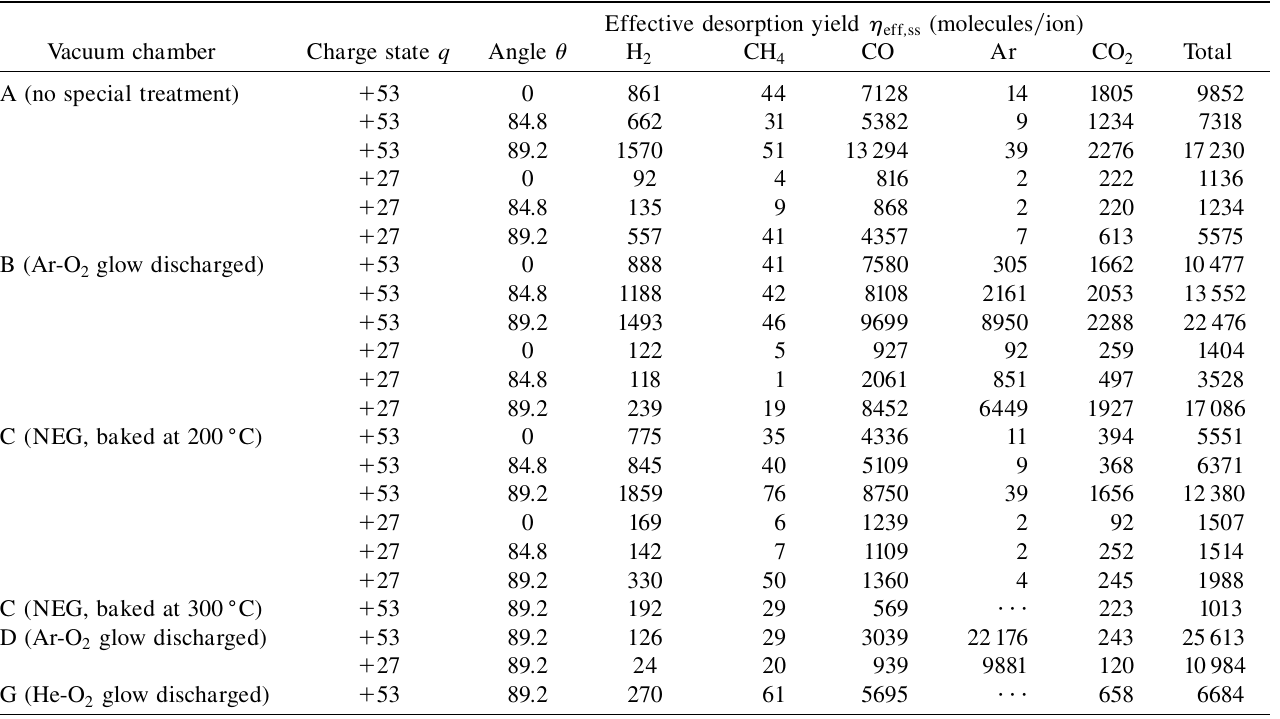
TABLE III. Effective desorption yields of the main desorbed gases measured for 4 : 2 MeV = u lead ions incident on different stainless steel vacuum chambers. Desorption yields are tabulated as a function of the ion charge state q and the impact angle (cid:6) . Normal incidence corresponds to (cid:6) (cid:6) 0 (cid:7)